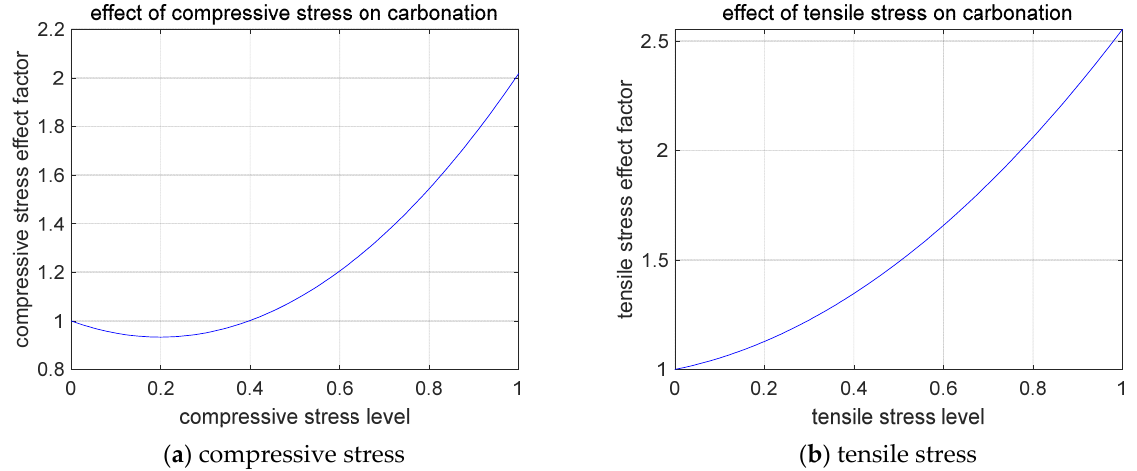
Figure 1. Effect of stress levels and stress types on depth of carbonation.